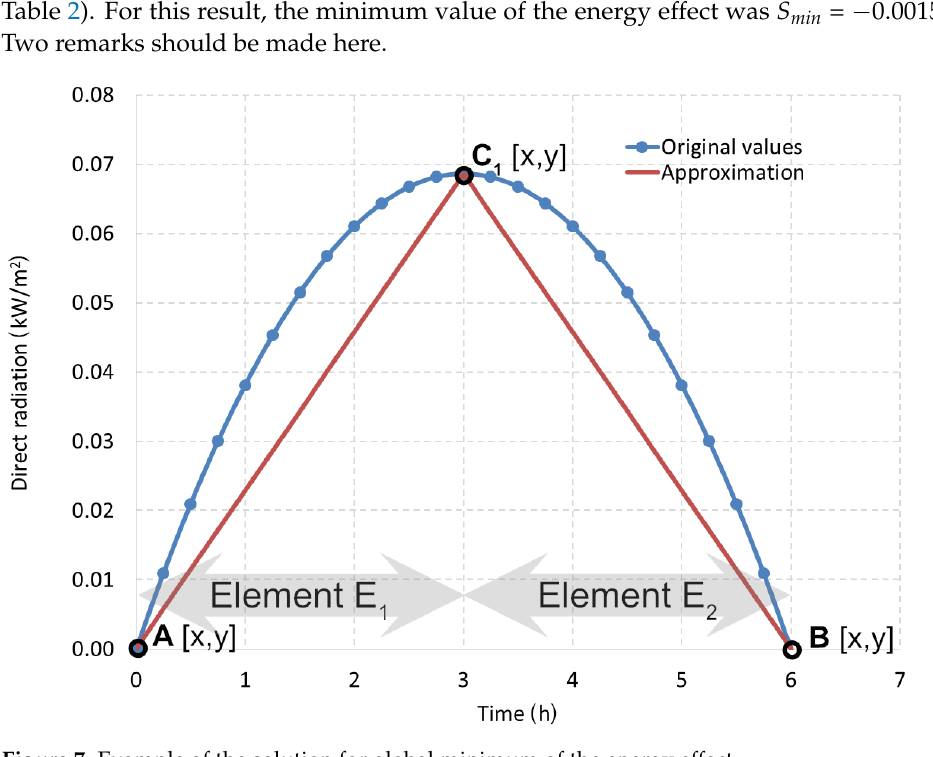
Figure 7. Example of the solution for global minimum of the energy